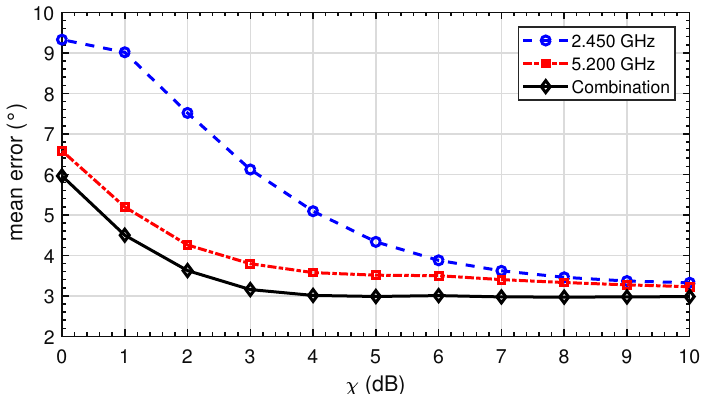
Figure 10. Mean DoA estimation error for D = 2.5m.